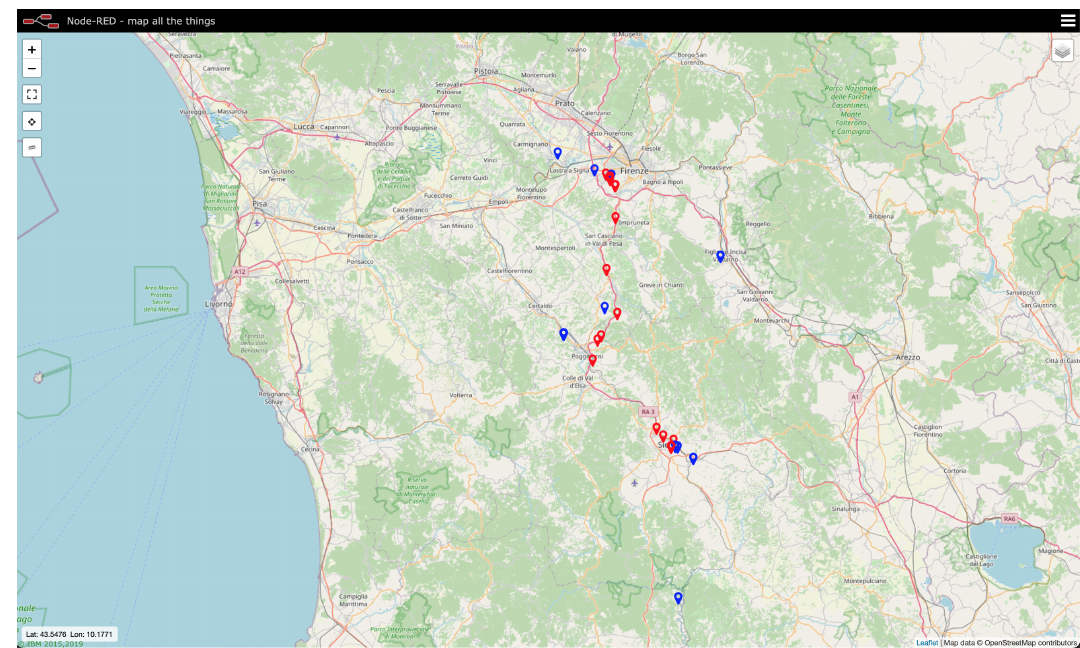
Figure 2. Snapshot of the tracking system web application showing the latest positions recorded by the device during its early testing stages: blue markers stand for locations coming from eNodeBs, while red markers stand for locations coming from